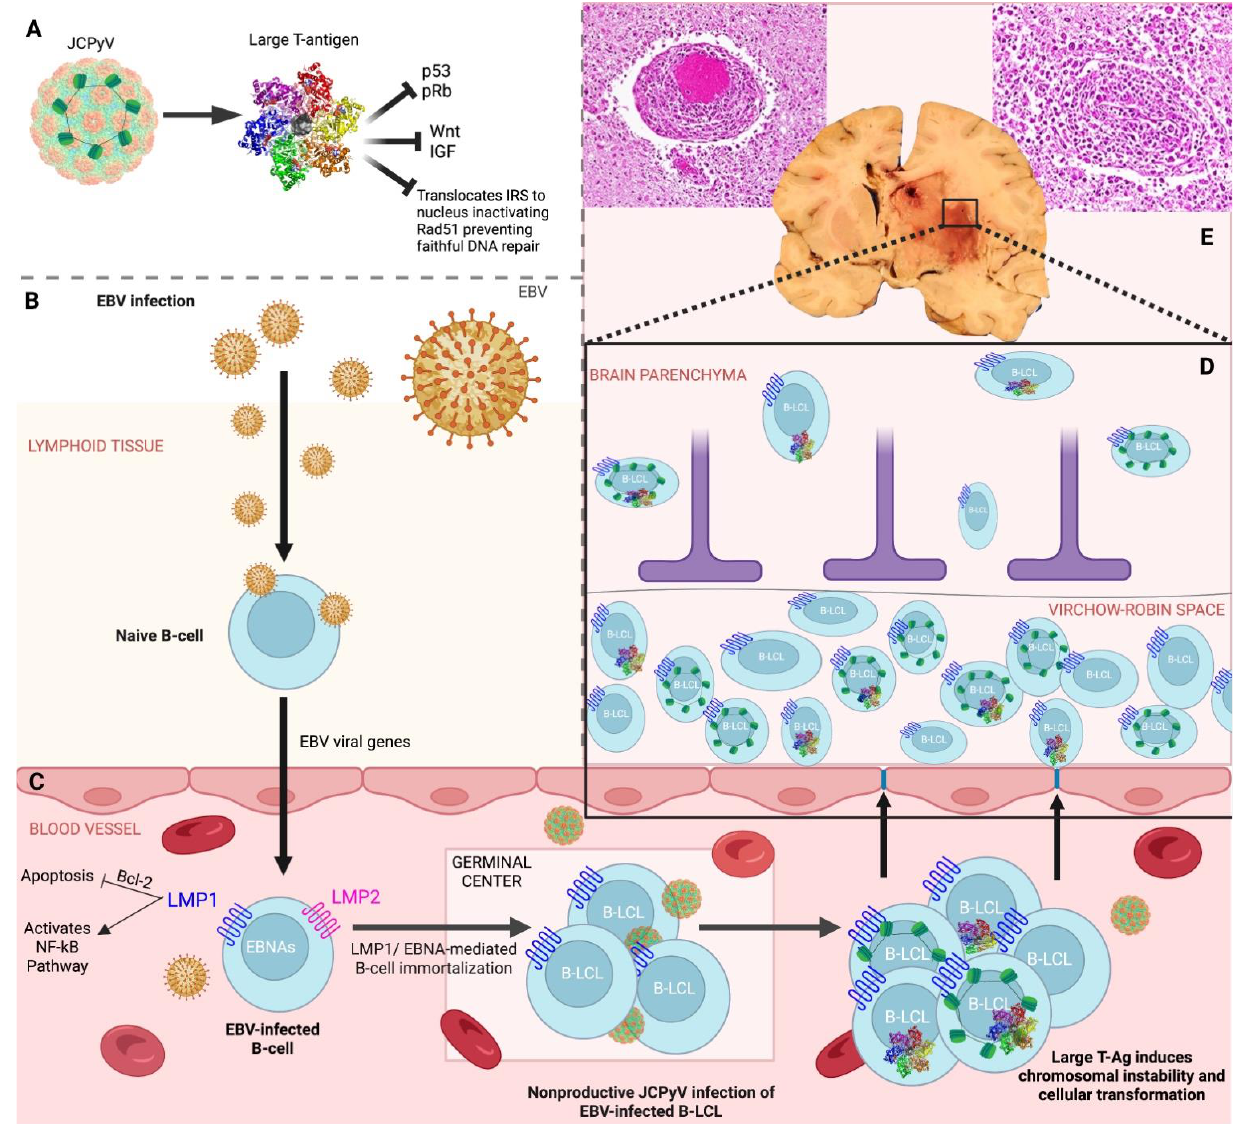
Figure 5. Model of EBV and JCPyV oncogenesis in primary CNS lymphomas: ( A ) JCPyV encodes for large T-Antigen (T-Ag) that inactivates tumor suppressors, p53 and pRb, dysregulates signaling pathways, Wnt and IGF, and prevents faithful DNA repair by initiating IRS translocation to the nucleus, inactivating Rad51. ( B ) EBV viral gene integration secondary to infection of naive B-cells during viral latent state. ( C ) EBV-infected B-cells express viral proteins, LMP1, LMP2, and EBNAs. LMP1 inhibits apoptosis via Bcl-2 and activates the NF- κ B pathway. EBV viral proteins LMP1 and EBNA mediate B-cell immortalization. JCPyV nonproductively infects EBV-immortalized B- lymphoblastoid cell line (B-LCL) and translates T-Ag that induces chromosomal instability, resulting in DNA-damaged, malignant B-cells that cross the blood brain barrier. ( D ) Pleomorphic, neoplastic B-cells proliferate in the Virchow–Robin space and infiltrate brain parenchyma. ( E ) Neoplastic cells form perivascular cuffs that break out of the Virchow–Robin space, resulting in an irregular, necrotic lesion in the basal